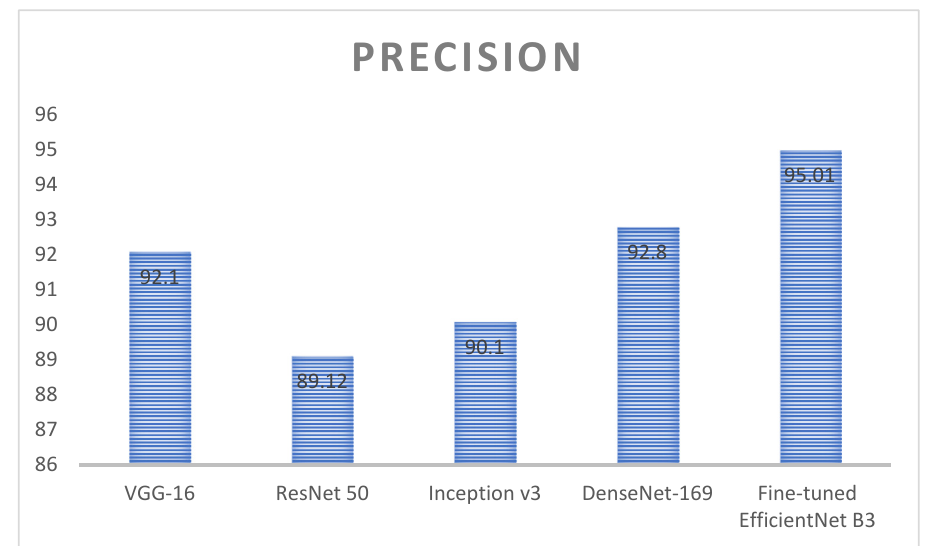
Figure 12. Analysis of precision value for the deep learning algorithms. Figure 13 represents the analysis of accuracy value for deep learning algorithms; Table 4. Performance evaluation of fine-tuned EfficientNet B3 with respect to accuracy and loss.